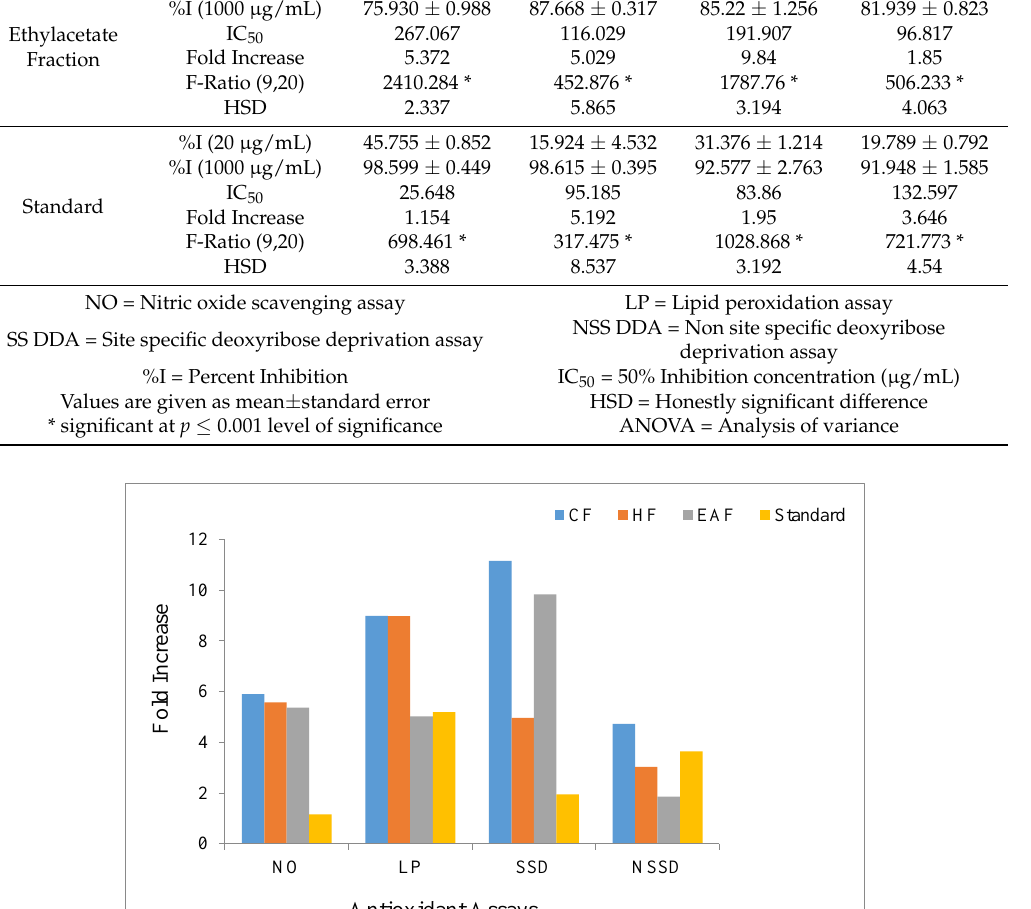
Figure 2. Assay wise fold increase in antioxidant activity of different fractions. [CF: chloroform fraction; HF: hexane fraction; EAF: ethyl acetate fraction; NO: Nitric oxide scavenging assay; LP: Lipid peroxidation assay; SSD: Site specific deoxyribose deprivation assay and; NSSD: Non- site specific deoxyribose deprivation assay].